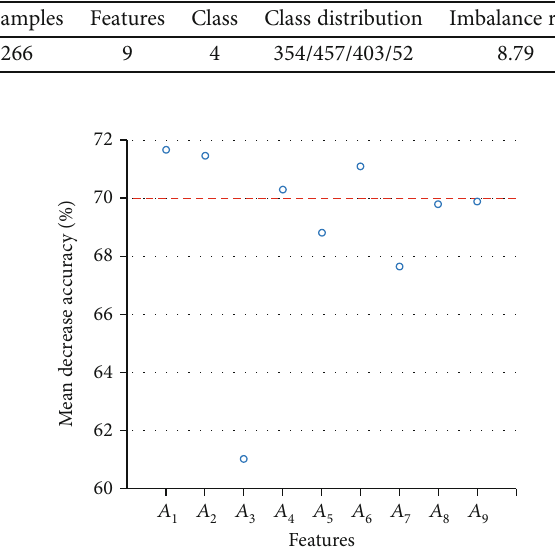
Figure 3: Importance of each feature based on Gini index.